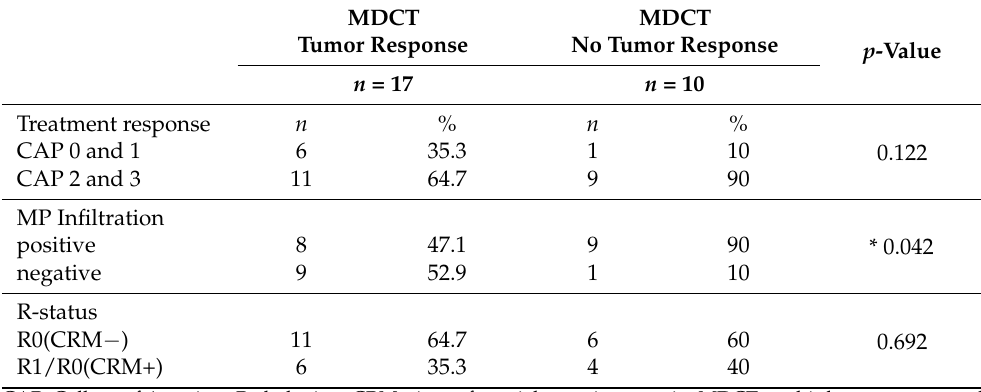
Table 4. Analysis of patients stratified according to MDCT-predicted tumor response, n = 27. MP infiltration status was distributed heterogeneously across MDCT tumor response status. Statistical significance was calculated by chi-squared test. * indicates a p -value ≤ 0.05.